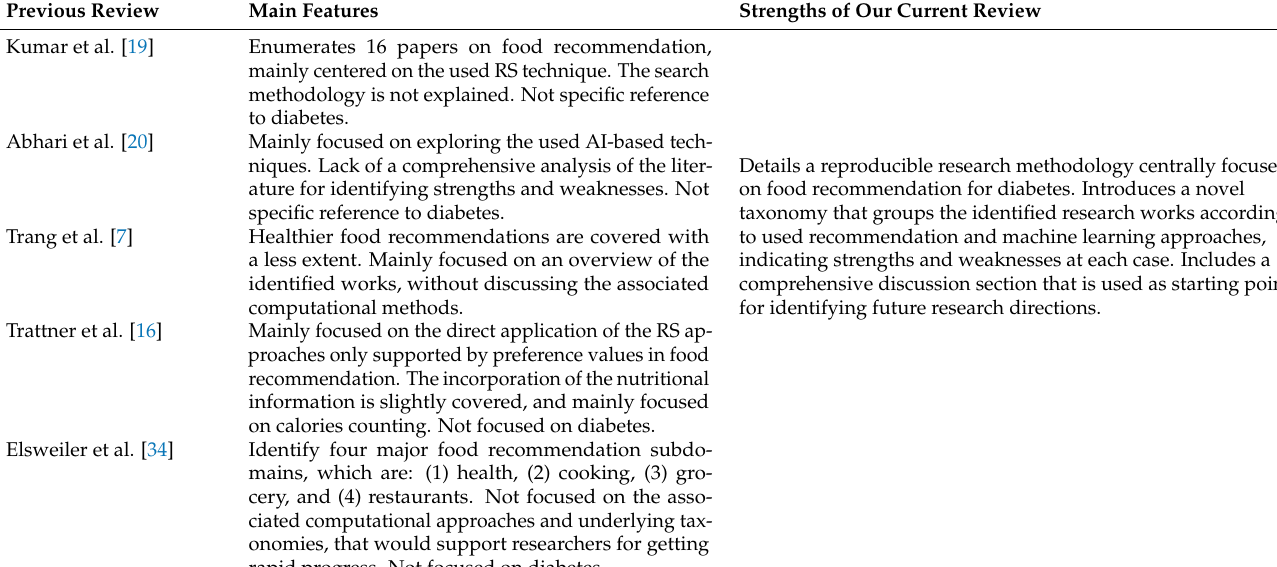
Table 5. Summary of the identified related works using optimization